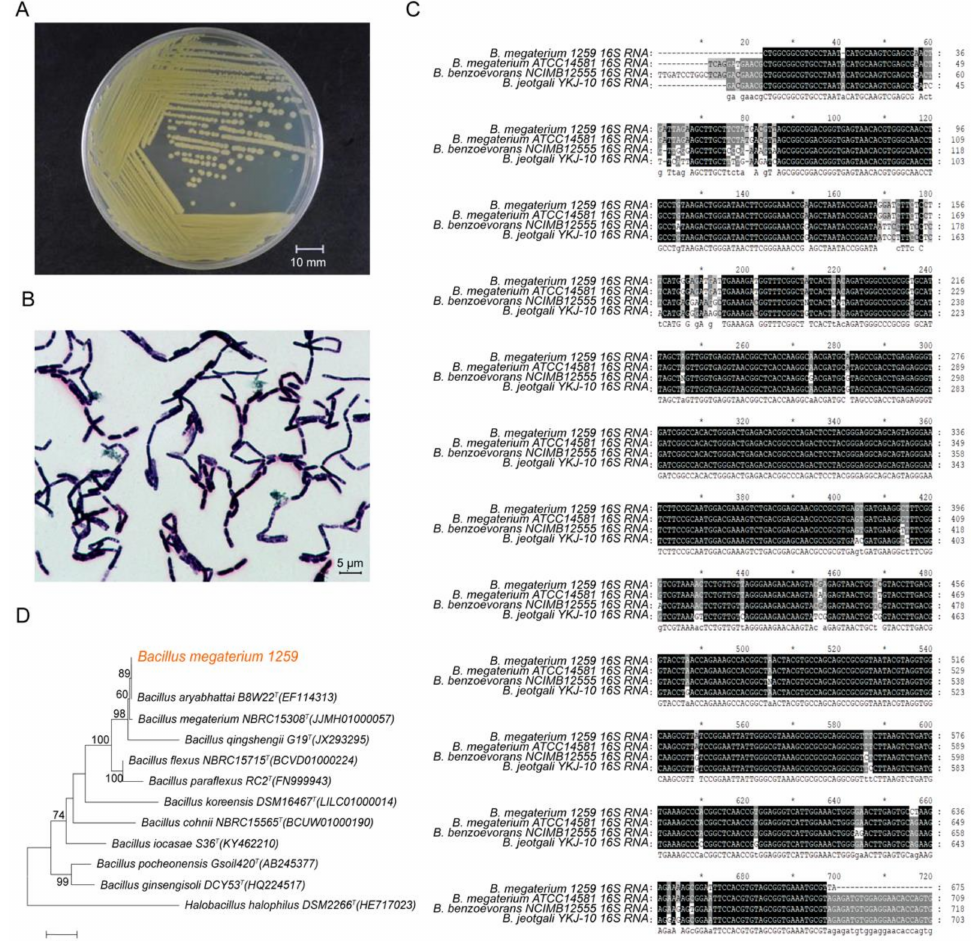
Figure 1. Identification of BM1259. ( A ) Culture and ( B ) the morphological characteristics of BM1259. The scale bar corresponds to 10 mm and 5 µ m. ( C ) Multiple alignment of 16S rRNA sequences from BM1259, Bacillus megaterium ATCC 14581 , Bacillus benzoevorans NCIMB 12555, and Bacillus jeotaglli YKJ-10 . Conserved residues are shown in an inverse rendition, and residues that are not identical but at least similar to the column consensus are shown in a gray background rendition. ( D ) Phylogenetic tree of the 16S rRNA sequence from BM1259, Bacillus megaterium NBRC 15308T (JJMH01000057), Bacillus qingshengii G19T (JX293295), Bacillus flexus NBRC 15715T (BCVD01000224), Bacillus koreensis DSM 16467T (LILC01000014), Bacillus cohnii NBRC 15565T (BCUW01000190), Bacillus iocasae S36T (KY462210), Bacillus pocheonensis Gsoil 420T (AB245377), and Bacillus ginsengisoli DCY53T (HQ224517); Halobacillus halophilus DSM 2266T (HE717023) was included as an